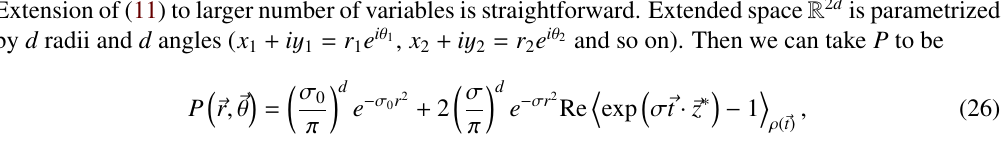
Figure 2. Positive representation of an exponential of a quartic monomial.